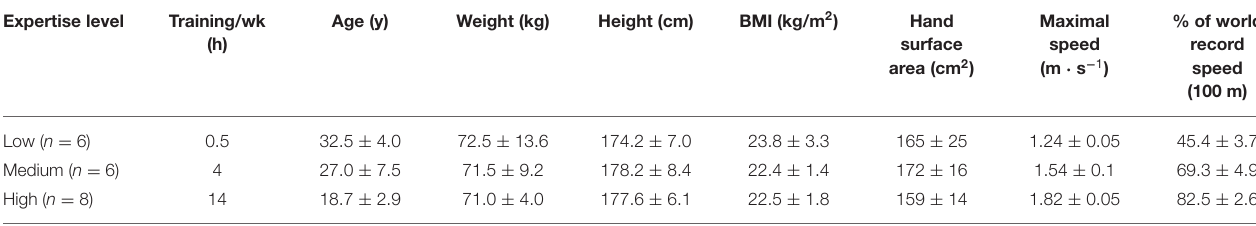
TABLE 1 | Main characteristics of the participants. Expertise level